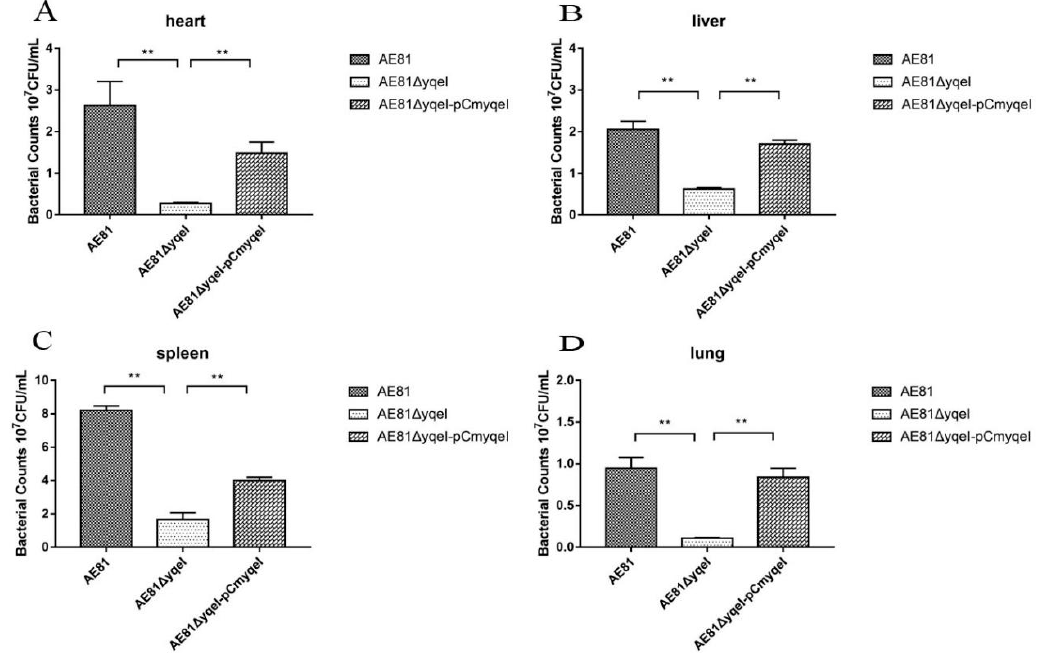
Figure 6. Bacterial colonization during systemic infection in chickens at 24 h post infection (**, p < 0.01). ( A ) The number of AE81, AE81 ∆ yqeI and AE81 ∆ yqeI -pCm yqeI was counted from the heart; ( B ) The number of AE81, AE81 ∆ yqeI and AE81 ∆ yqeI -pCm yqeI was counted from the liver; ( C ) The number of AE81, AE81 ∆ yqeI and AE81 ∆ yqeI -pCm yqeI was counted from the spleen; ( D ) The number of AE81, AE81 ∆ yqeI and AE81 ∆ yqeI -pCm yqeI was counted from the lung.